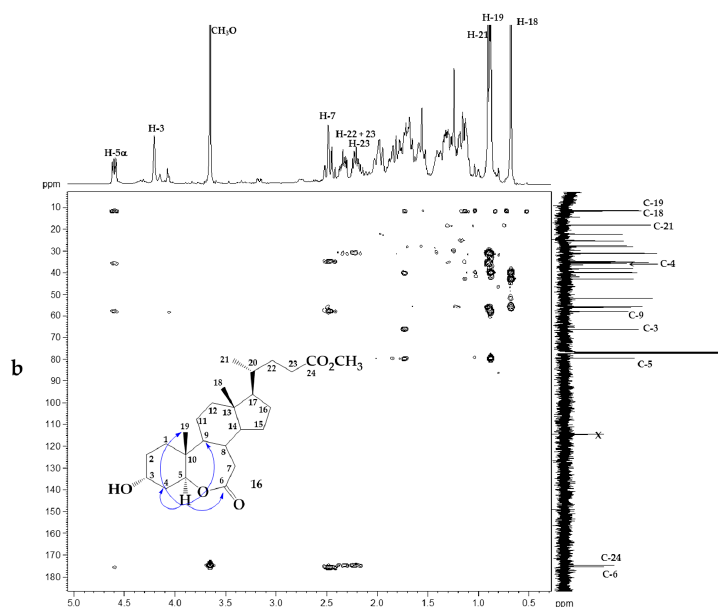
Figure 3. ( a ) Inverse detection heteronuclear-correlated 2D 1 H- 13 C HMBC contour plot and major observed 2 J HC and 3 J HC correlations for H-5 α in 7-oxalactone 15 and ( b ) for 6-oxolactone 16 .